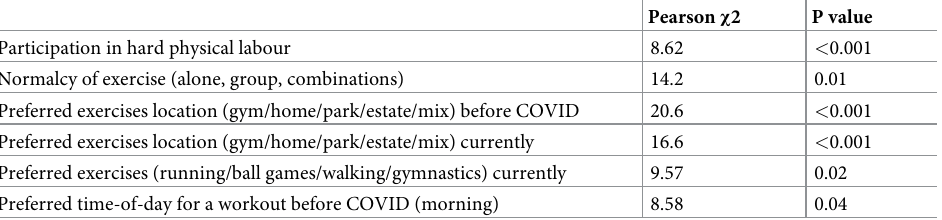
Table 4. Association between zone (reference, low socioeconomic) of residence and various